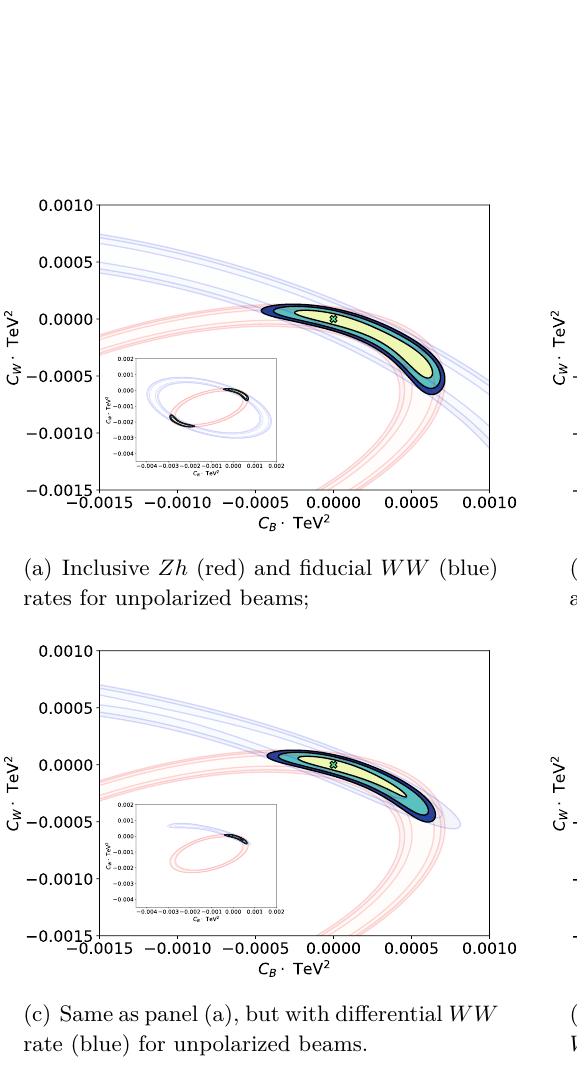
Figure 11 . Same as figure 4, but for E cm = 30